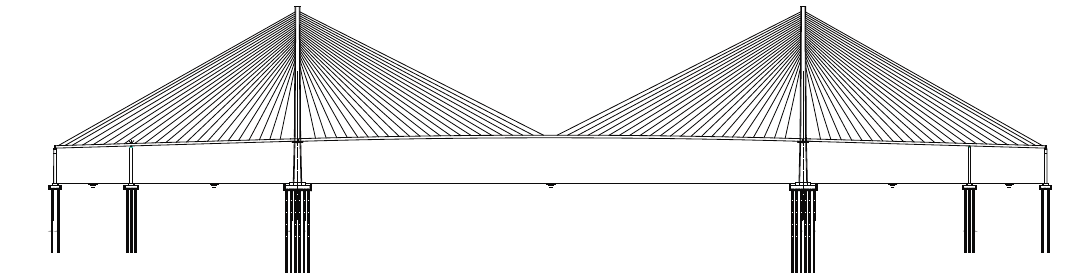
Figure 3: General view of a cable-stayed bridge. Table 1: The value of analysis parameters.